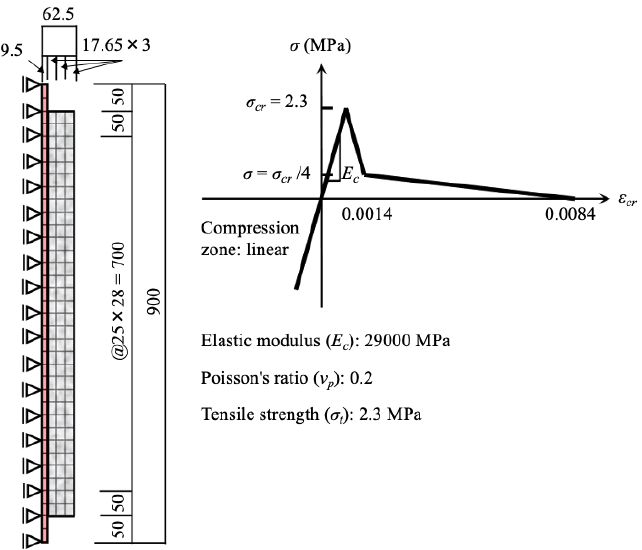
Figure 8. Axial symmetry model and mechanical properties of concrete.